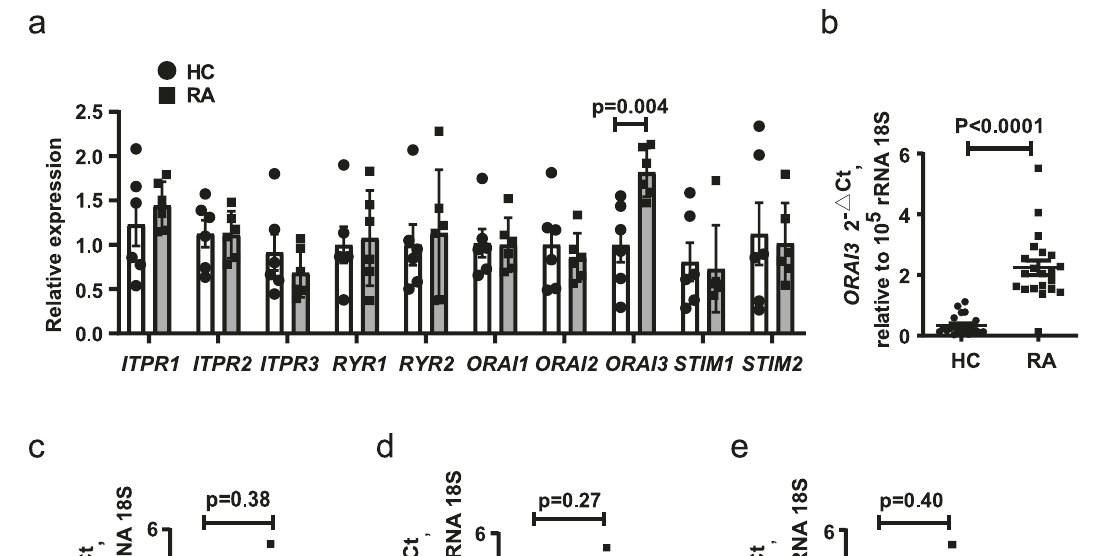
mediates agonist-activated, store-independent calcium entry 31 , in contrast to the store-operated CRAC channel that mediates the Ca 2 + in fl ux after TCR triggering and that is an exclusive ORAI1 polymer 32 – 34 . To determine whether the ARC channel is func- tional in naive CD4 + T cells, we monitored cytoplasmic calcium concentrations after AA stimulation by ratiometric Fura Red fl uorescence. We found a rapid in fl ux of Ca 2 + ions upon sti- mulation (Fig. 3a). After the peak response, Ca 2 + concentrations declined again, but remained slightly elevated. This peak response